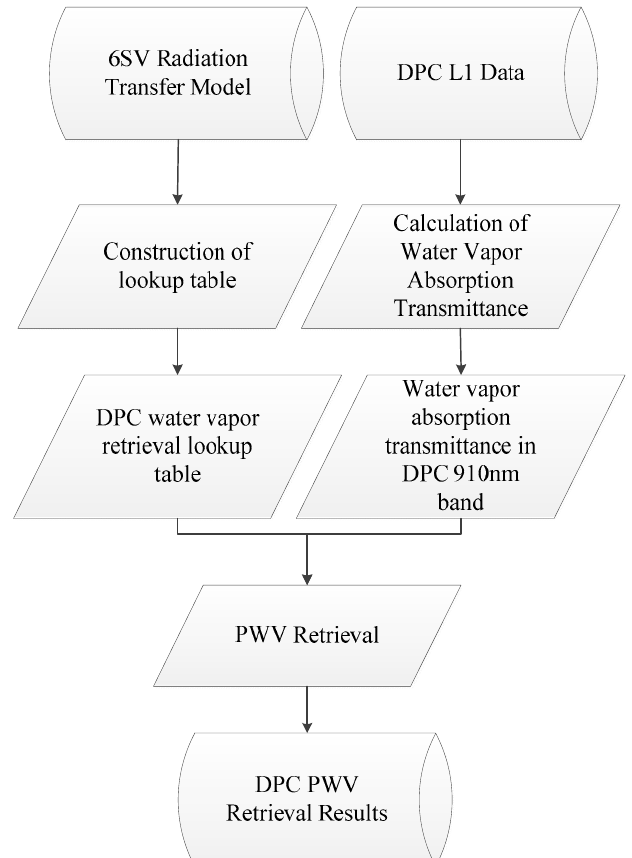
Figure 2. Flow chart of DPC water vapor retrieval.